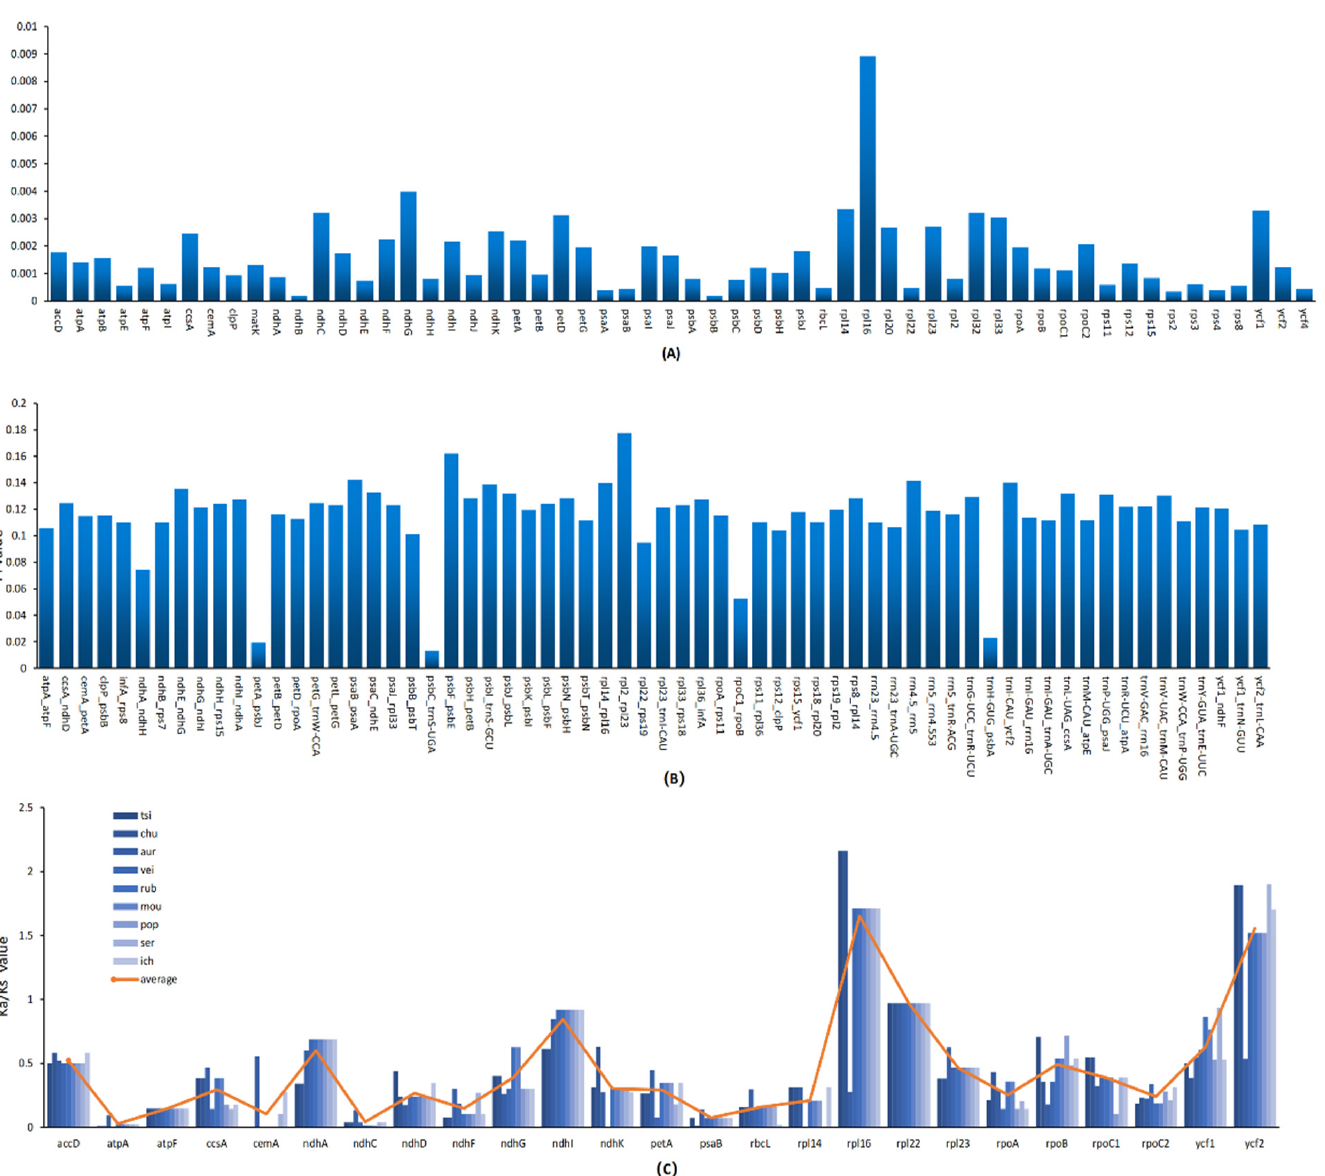
Figure 6. Nucleotide diversity in chloroplast genomes of nine species of Litsea . The abscissa represents the position, and the red line represents the average of the nucleotide variations of the nine species. ( A ) Pi values for each gene region. ( B ). Pi values for each intergenic region. ( C ) Ka/KS values for each